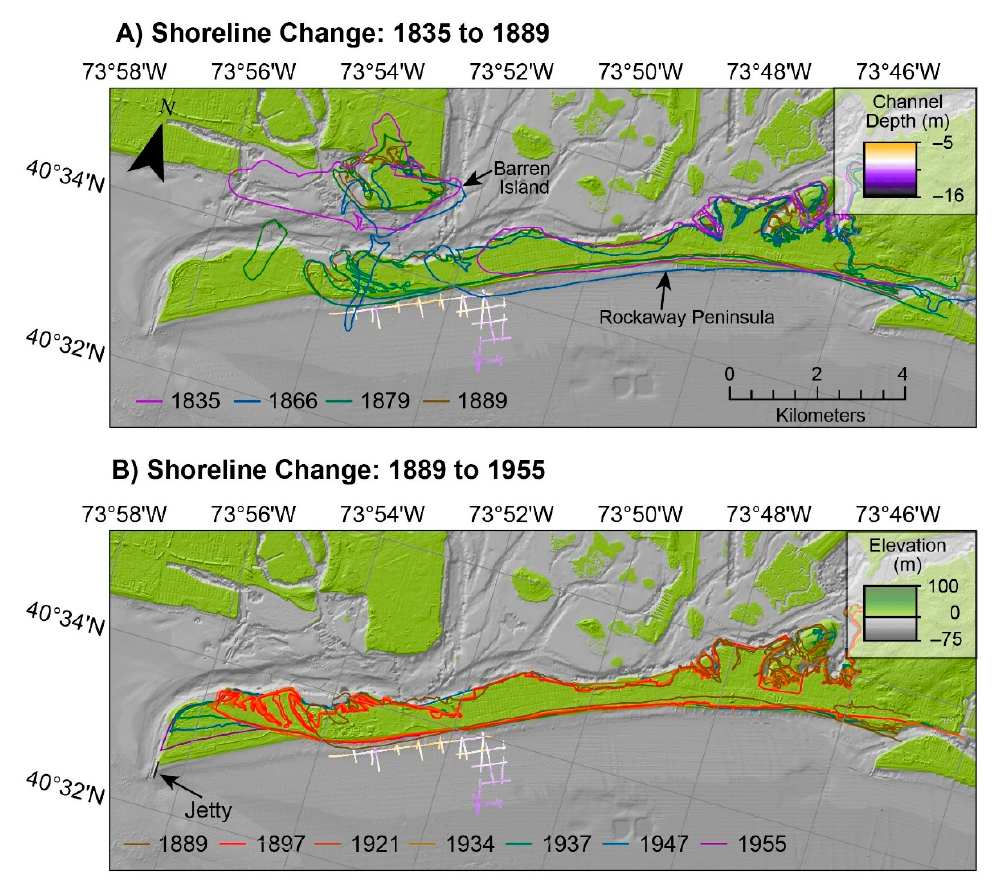
Figure 2. Rockaway shoreline evolution. Shorelines were digitized from maps from the NOAA Historical Map and Chart Collection (historicalcharts.noaa.gov). ( A ) Shoreline change of the Rockaway Peninsula from 1835–1889 was characterized by rapid westward progradation and growth. The shoreline of Barren Island, located northwest of the peninsula, is also shown through time. ( B ) The period from 1889–1995 is characterized by slow westward growth of the island until 1937, when the island elongated westward. Further growth from 1937–1955 is characterized by seaward progradation.